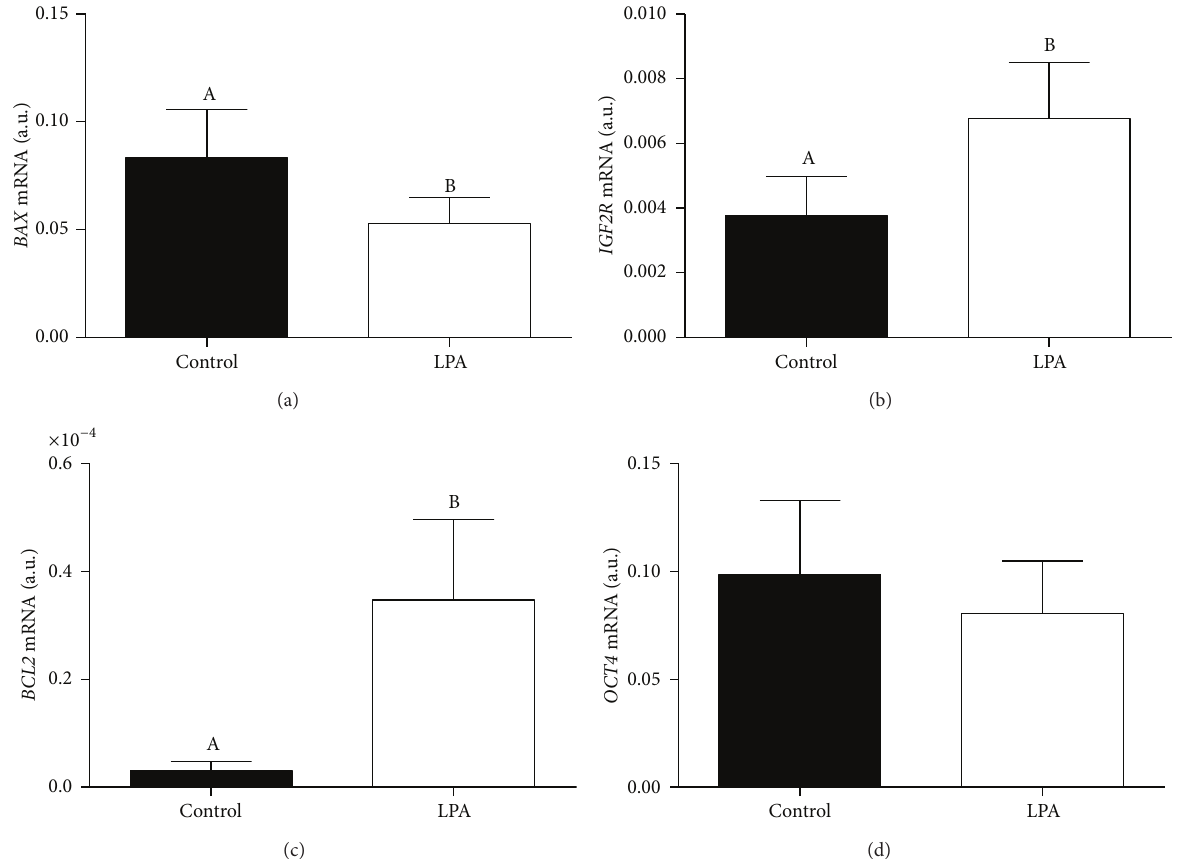
Figure 7: Effect of LPA stimulation on transcription levels of genes coding for embryo quality markers ((a) BAX ; (b) IGF2R ; (c) BCL2 ; and (d) OCT4 ) in bovine in vitro produced blastocysts. Columns with different superscripts differ significantly: AB, 𝑃 < 0.05 .